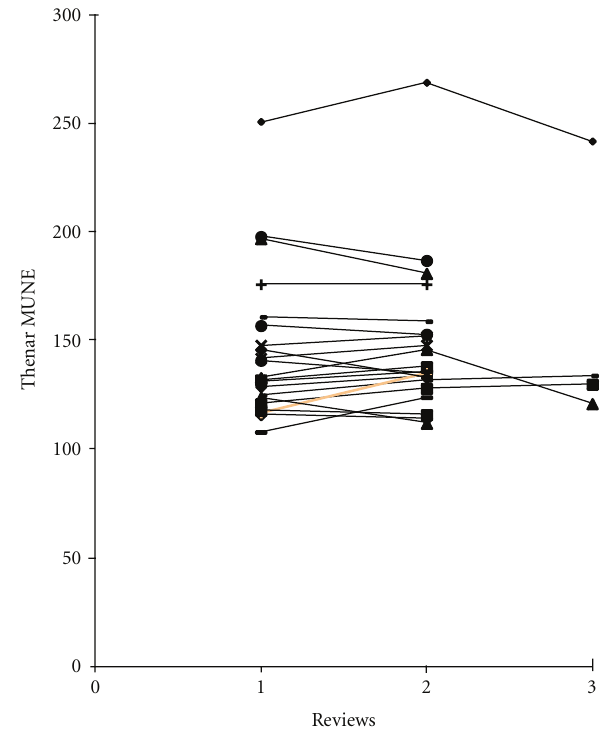
Figure 1: Reproducibility of thenar MUNE in population controls on separate reviews over a one-year period.